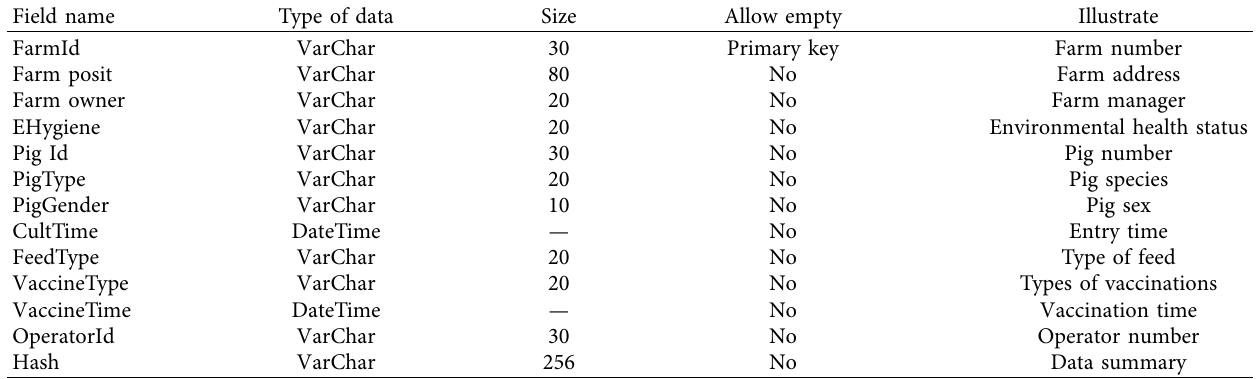
Table 3: Breeding information table.